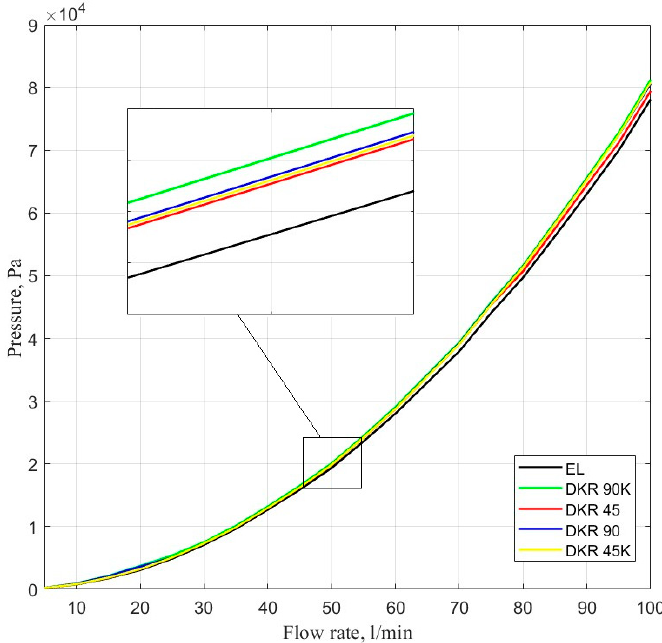
Figure 9. Fluid pressure losses at the angular fitting connections.